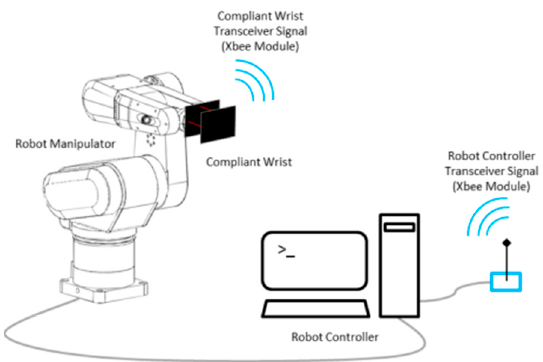
Figure 4. Compliant wrist assembly mounted on a manipulator and wireless communication with robot controller.